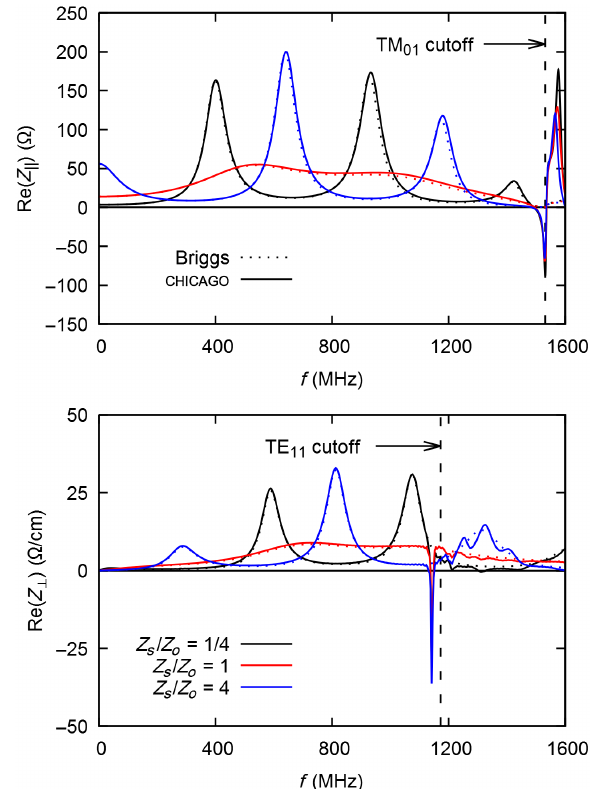
FIG. 2. Z k (top) and Z ⊥ (bottom) for idealized pillbox gap with b ¼ 7 . 5 cm, d ¼ 3 . 5 cm, R ¼ 30 cm, with terminating surface resistances of Z s =Z o ¼ 1 = 4 (black), 1 (red), and 4 (blue). Results are shown for the theory of Briggs (dotted lines) and CHICAGO simulations (solid lines). For the CHICAGO results, L ¼ 60